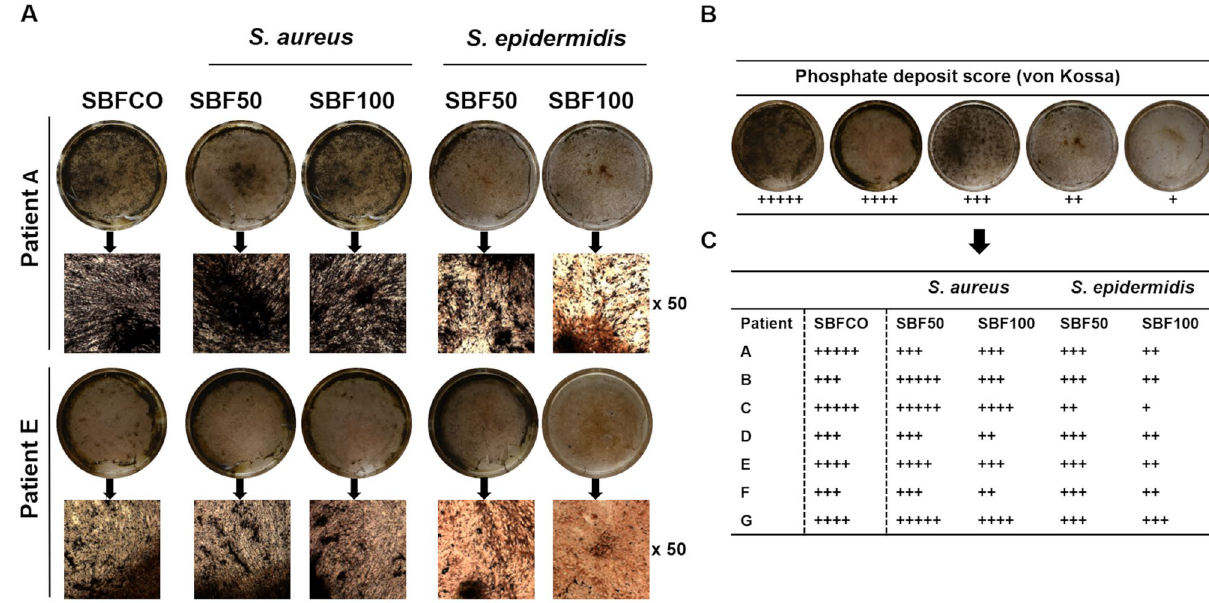
Figure 7. SBF impacts phosphate deposits produced by osteoblasts. The phosphate deposits were dyed with von Kossa stain after incubation for 28 days; representative images from 2 donors are shown ( A ). Phosphate deposits score ( B ). Semi quantitative evaluation of all 7 patients by using the calcium deposit score ( C